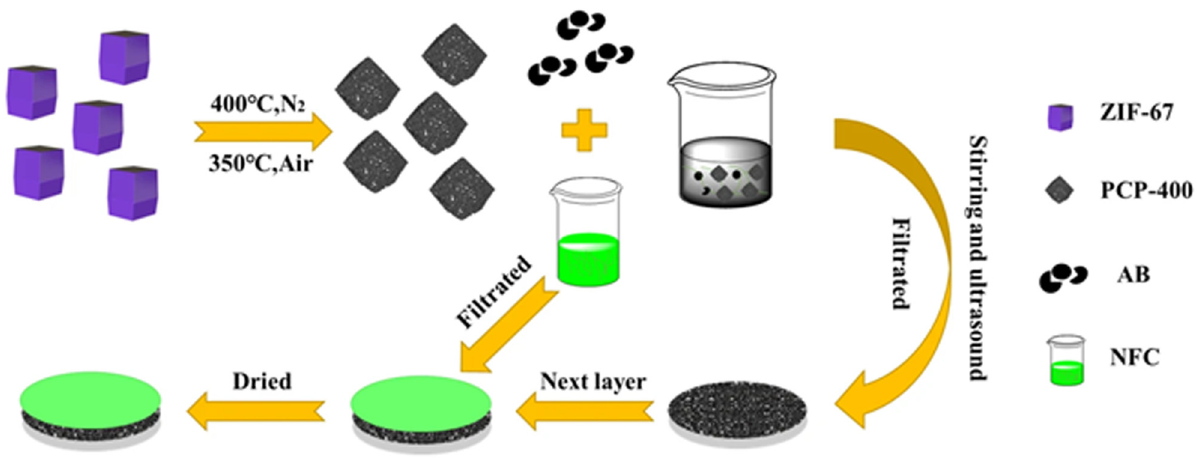
Figure 9: Schematic of the preparation of the NFC/PCP and NPC fl exible supercapacitor electrodes. Reproduced from ref. [ 145 ] , Copyright 2021, Springer